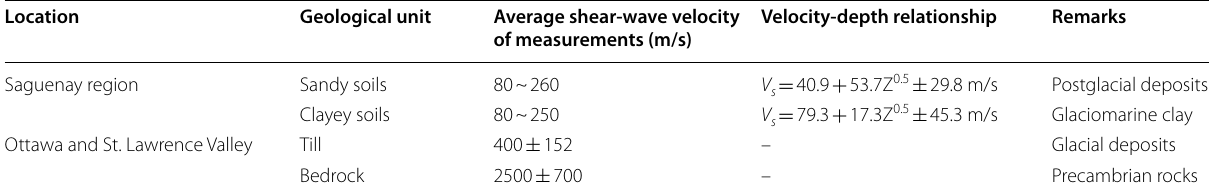
Table 5 Representative shear-wave velocity of bedrock and surficial sediments (after Nastev et al. 2016; Foulon et al. 2018) Location